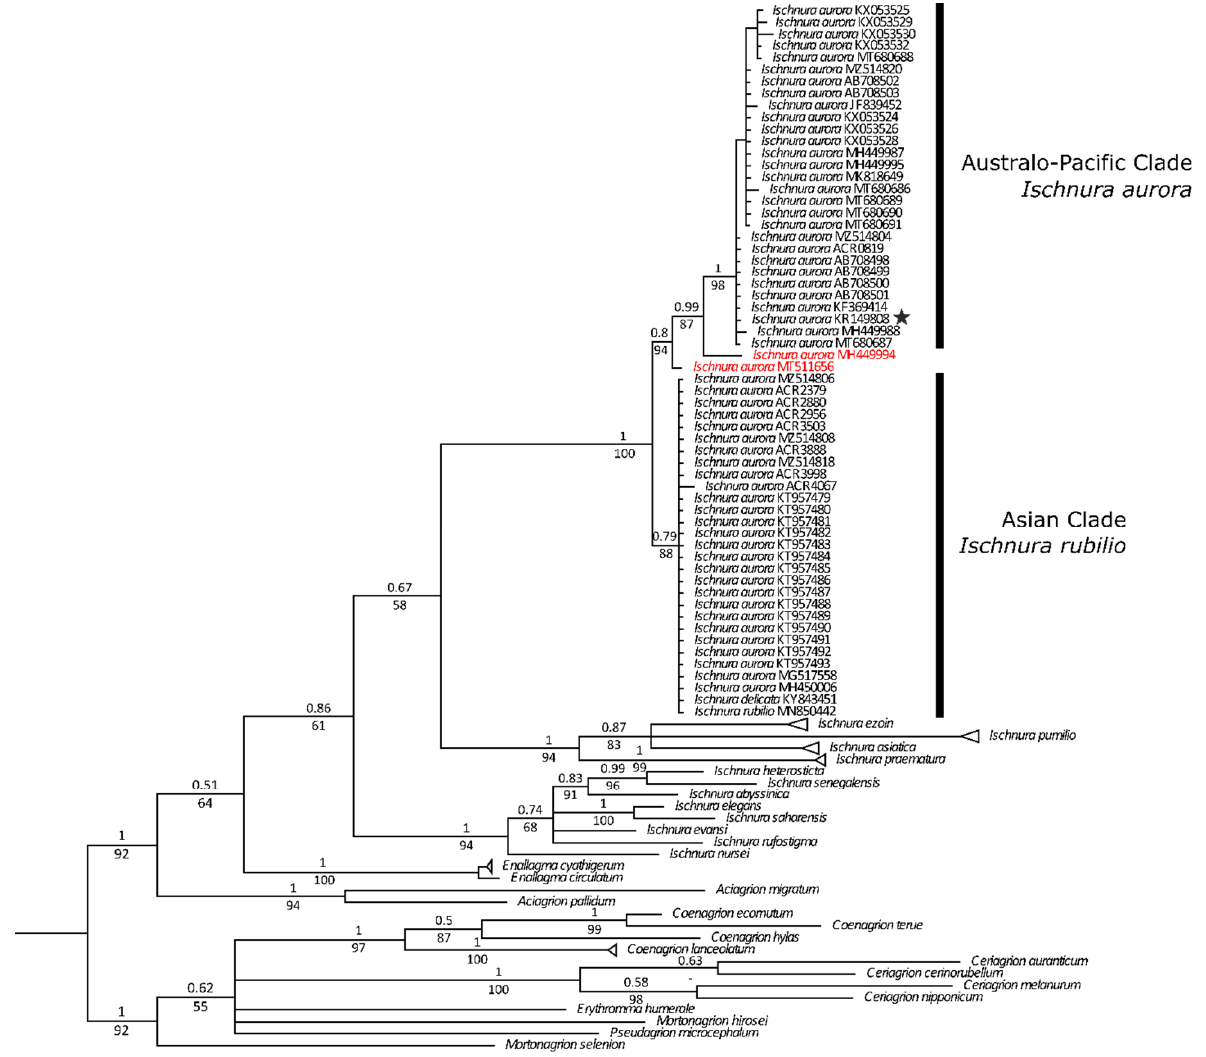
Figure 2. Tree representing the phylogenetic relationships among the Ischnura species analysed in this study, using mitochondrial DNA ( COI ) sequence data. Numbers above and below branches represent Bayesian posterior probability and maximum likelihood bootstrap values, respectively. Clades are labelled according to the ASAP proposed species delimitation. The star within the Australo-Pacific clade indicates the I. aurora individual from Kerala (India) retrieved from GenBank, while the specimens in red are the two I. aurora from New Guinea and India that are identified as different taxonomic units by ASAP (see also Table A1 and Figure A7a).